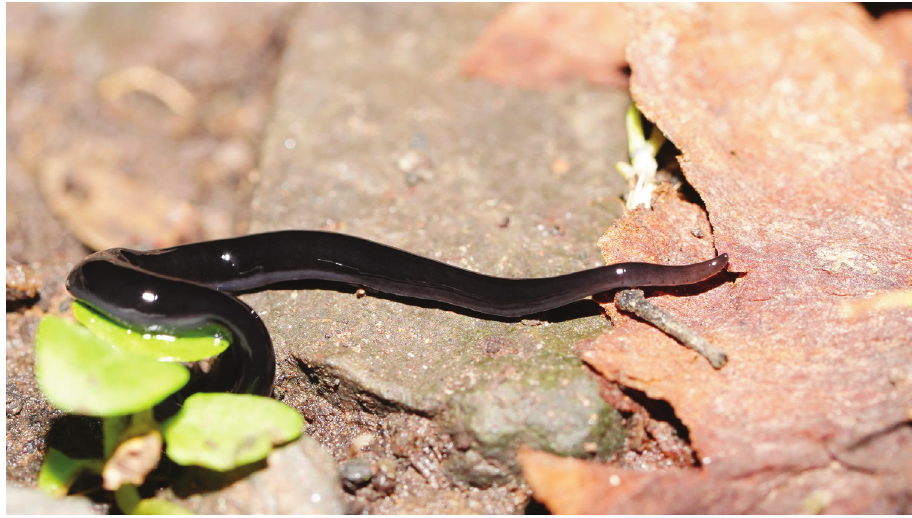
Figure 2. Living flatworm Australopacifica atrata (Steel, 1897), dorsal